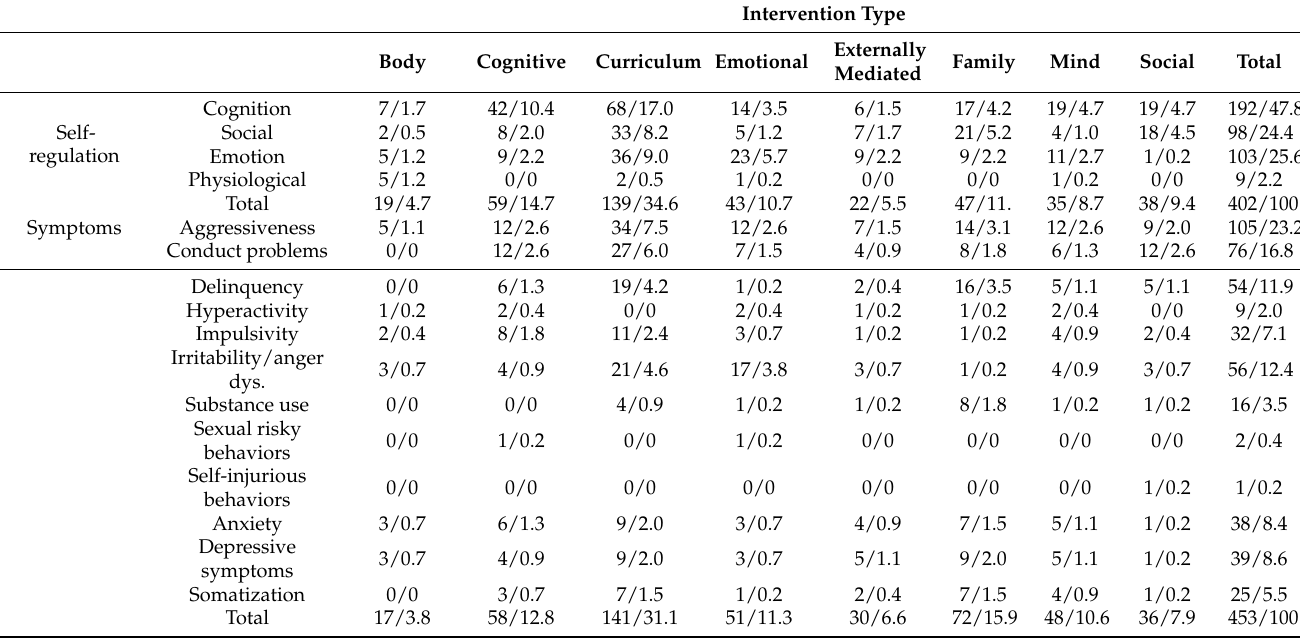
Table 3. Number/percentage of occurrence of SR processes and psychopathological symptoms in each type of